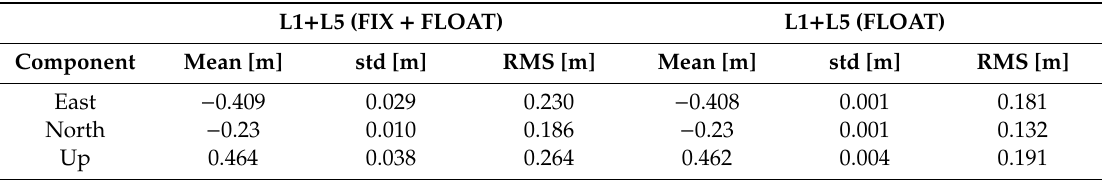
Table6. ComparisonbetweenFIX + FLOATsolutionswiththeFLOAT-onlyones, iftheL1 + L5frequencies are considered.